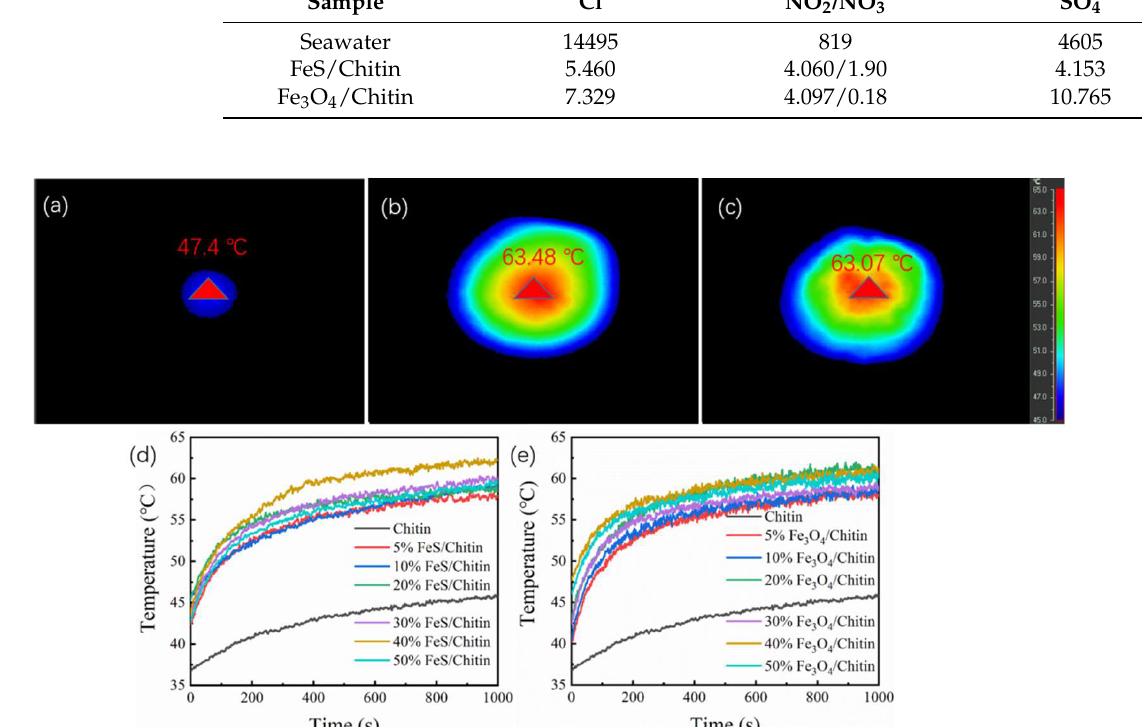
Figure 7. Thermal imaging of chitin and FeS/chitin and Fe 3 O 4 /chitin with different loading ratios: ( a ) maximum temperature of chitin, ( b ) FeS/chitin and ( c ) Fe 3 O 4 /chitin. Linear diagram of ( d ) FeS/chitin and ( e ) Fe 3 O 4 /chitin.